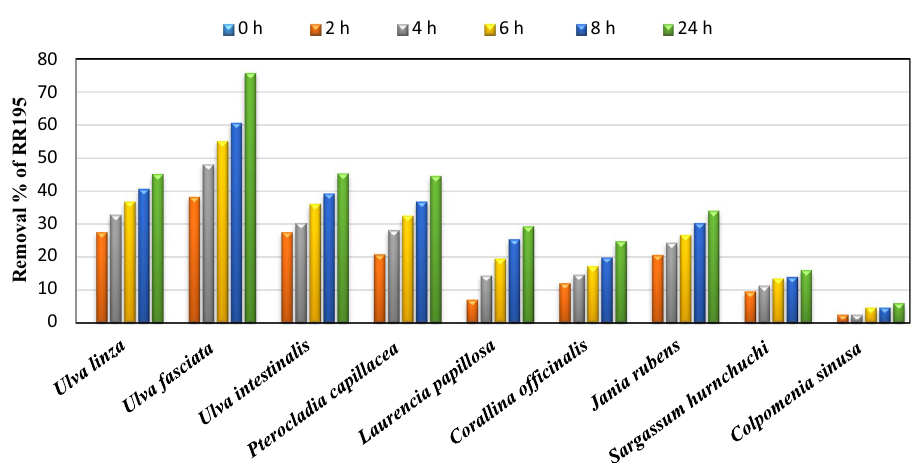
Fig. 8 Removal percentage of Reactive Red 195 by the nine studied dried algal species